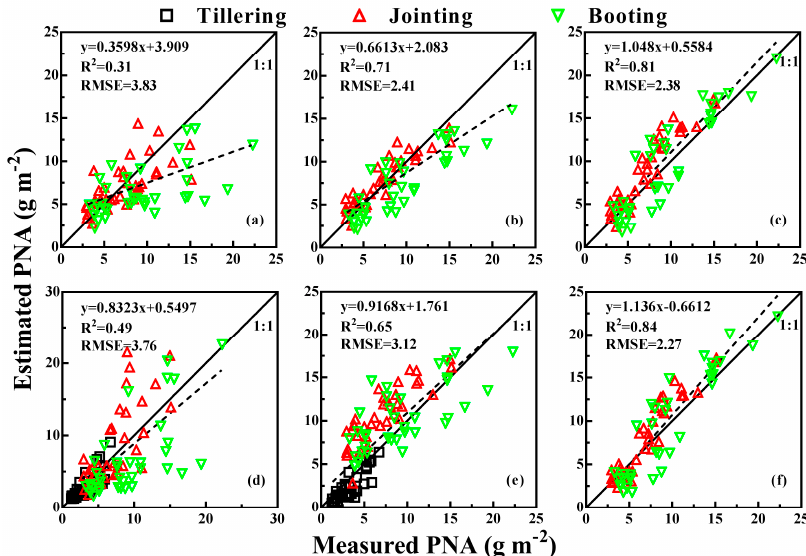
Figure 8. The 1:1 relationship between the estimated and measured plant N accumulation (PNA, g m − 2 ) in rice based on NGRDI-MCA ( a ), GNDVI-MCA ( b ), CI red edge ( c ), NGRDI-RGB ( d ), GNDVI-CIR ( e ), and DATT ( f ). Only RGB and CIR images have tillering data. The solid line indicates the 1:1 line and the dashed line indicates the regression line.